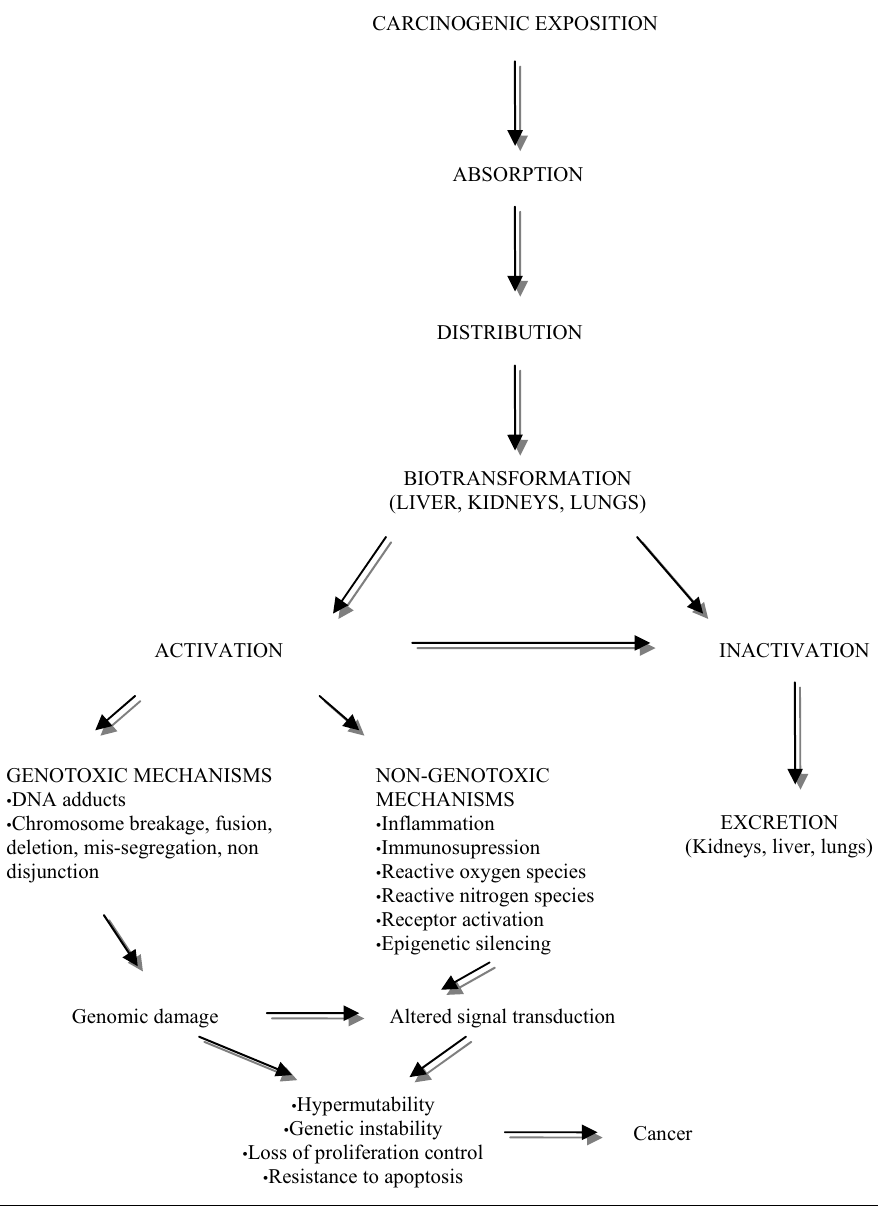
Fig. 3 – Metabolic activation of chemical compounds and genotoxic and non-genotoxic effects of